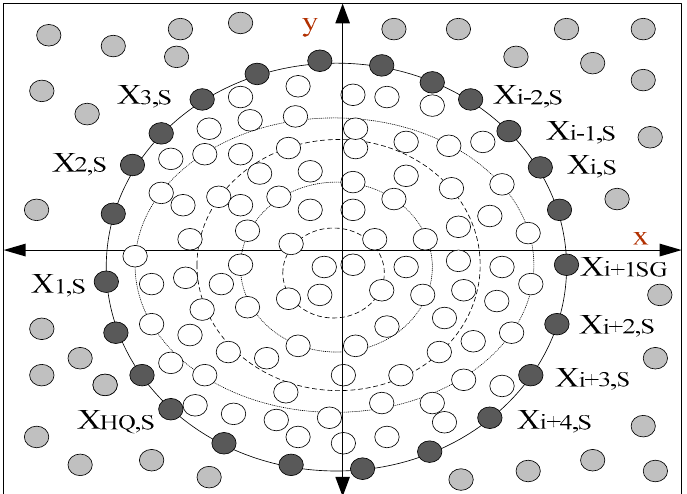
Figure 2. Local Neighborhood Search Structure.